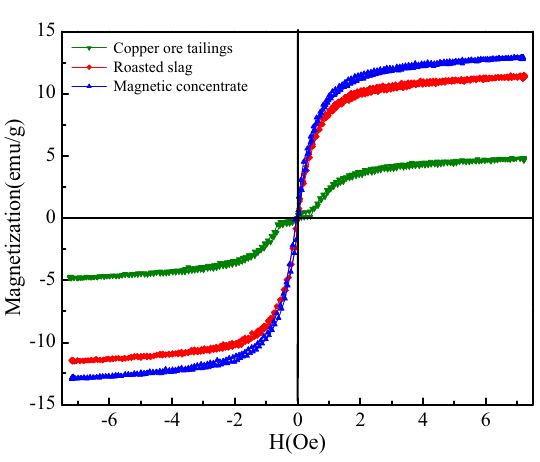
Figure 12: Magnetization curve of copper ore tailings, roasted slag, and magnetic